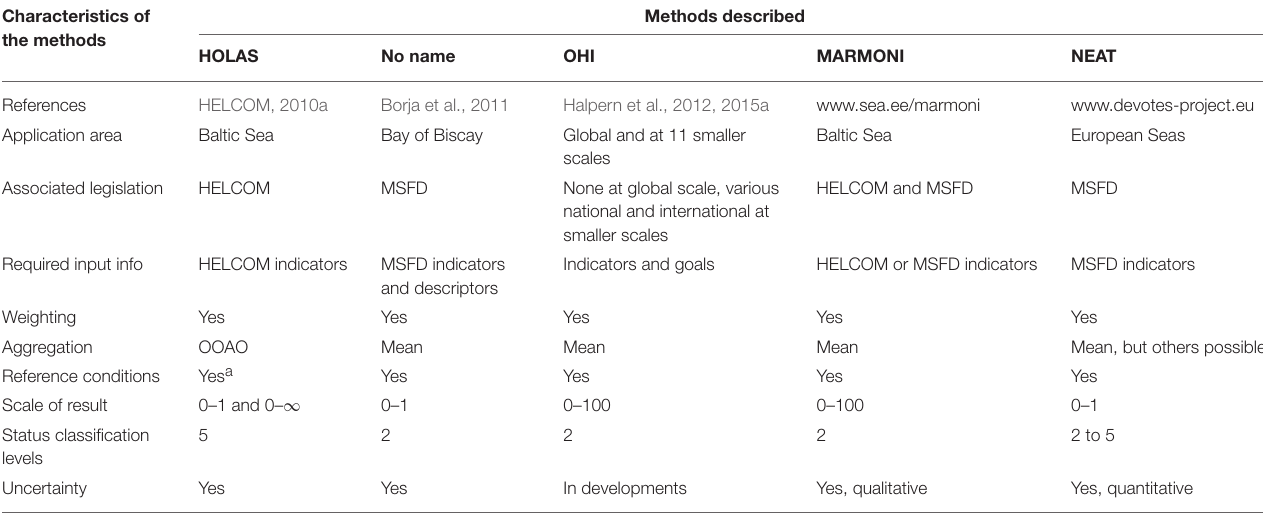
TABLE 1 | Summary of the main characteristics of the methods described here. Characteristics of the